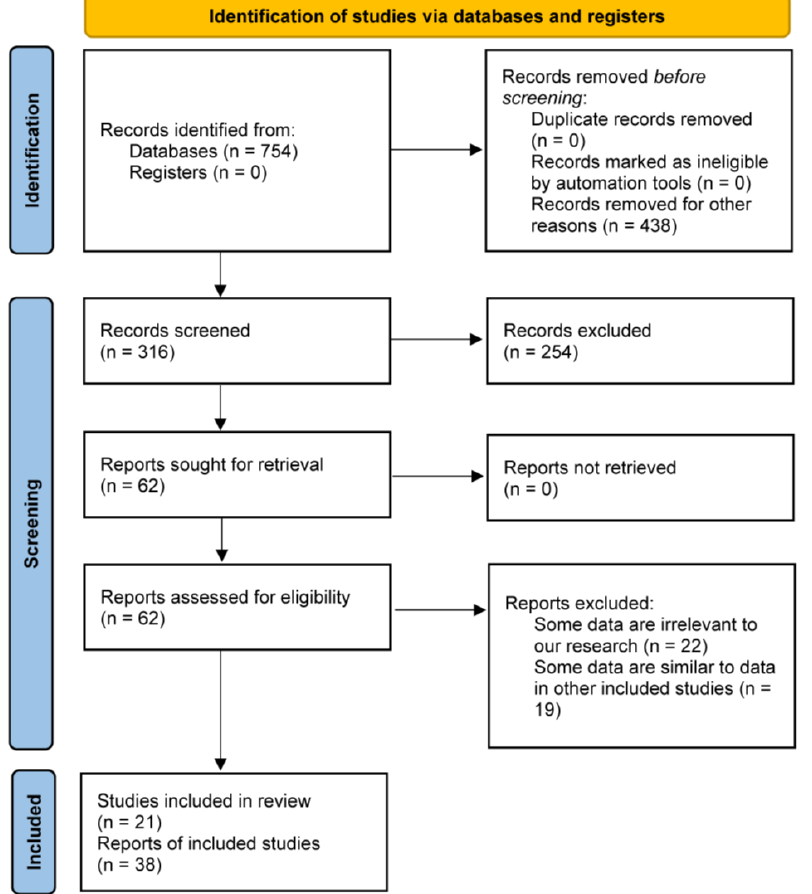
Figure 3. Methodology for literature selection according to the PRISMA 2020 flow diagram.